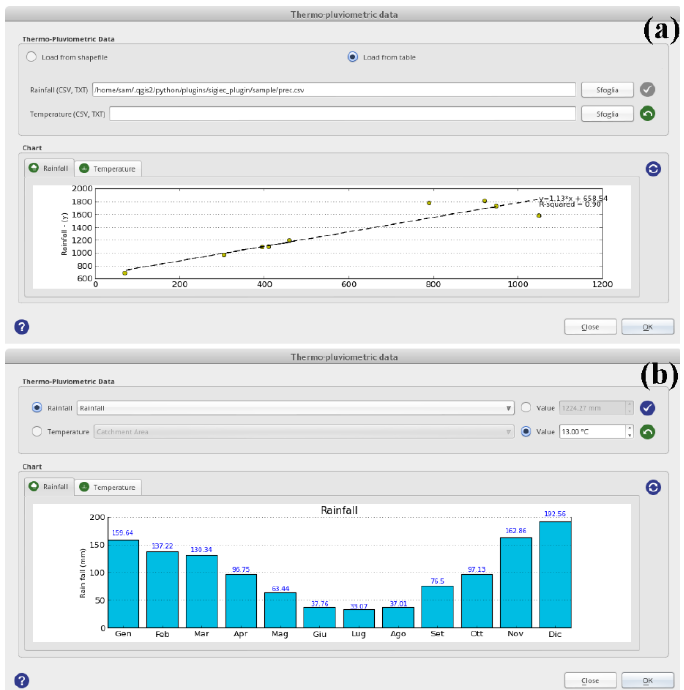
Figure 4. Graphical User Interface of stage 3. ( a ) Linear regression obtained after the input of the thermo-pluviometric data as a table. ( b ) Histogram plot showed by the plug-in if the user loads the data as a point vector layer.